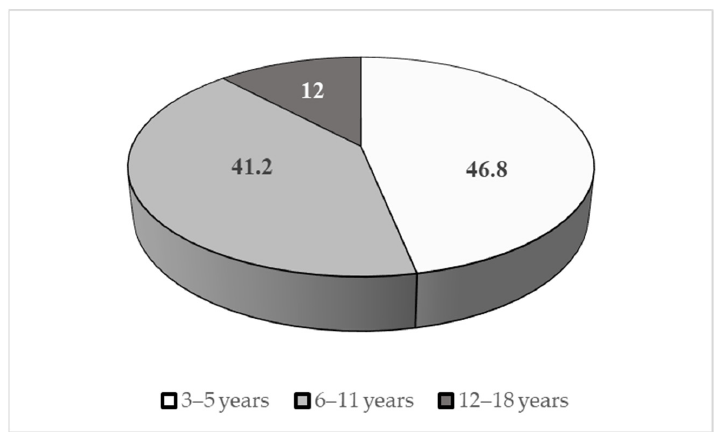
Figure 2. Age distribution of the sample